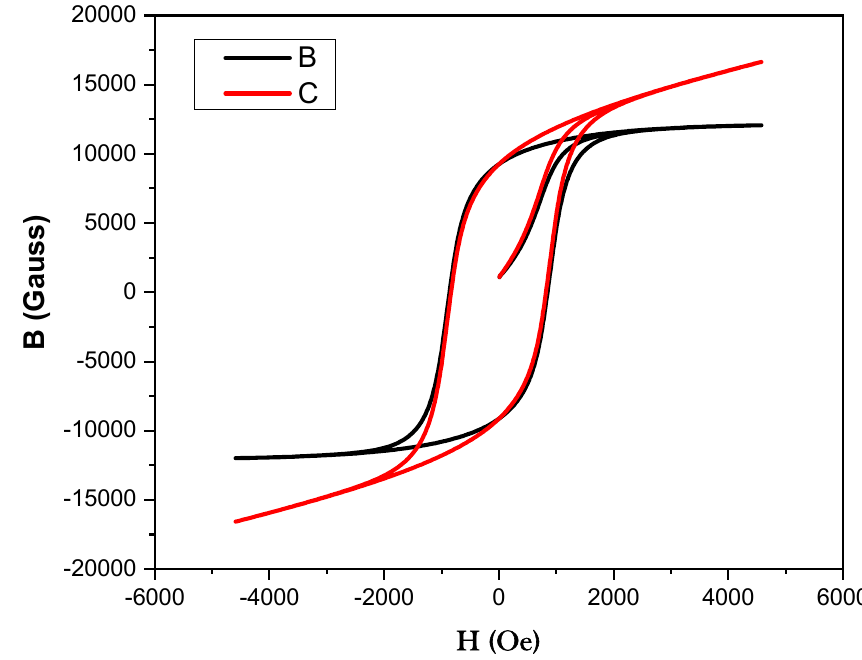
Figure 7. Magnetic hysteresis loop of Sample B and Sample C after complete treatment. Table 2. Magnetic properties of the studied Sample A alloy, Sample B alloy and Sample C alloy after complete treatment investigating the alloy system.